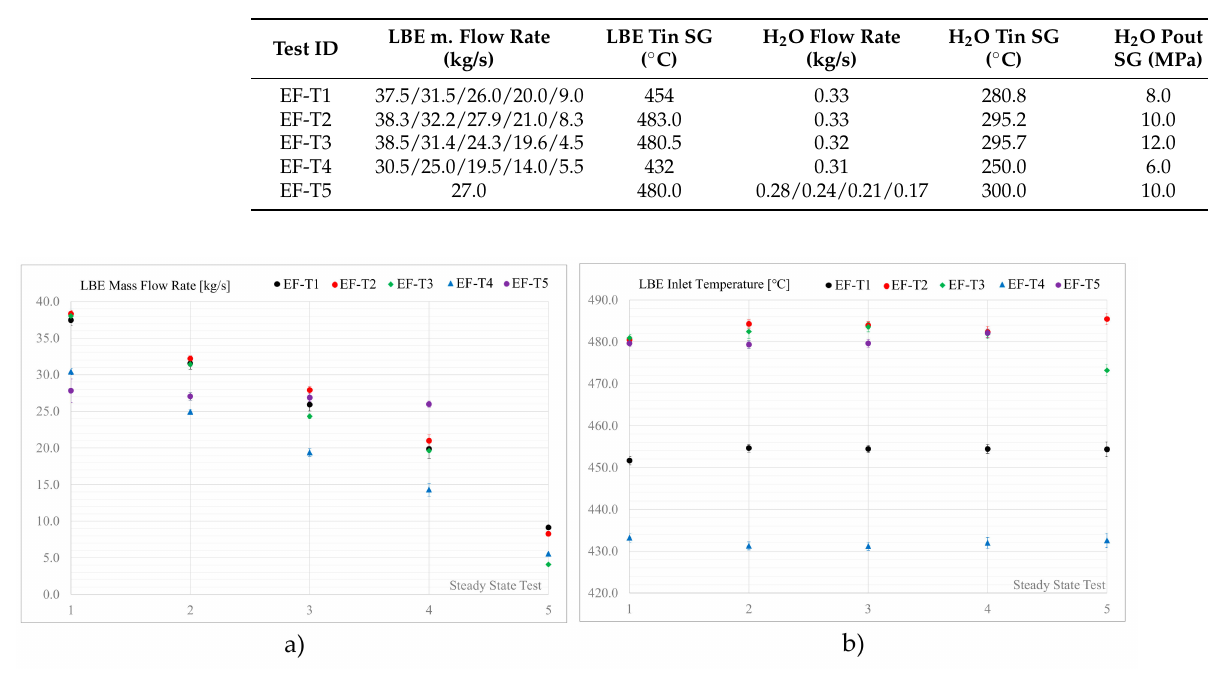
Figure 4. LBE average mass flow rate and relative standard deviation at steady states: ( a ) and LBE average inlet temperature and relative standard deviation at steady states; ( b ) for all the